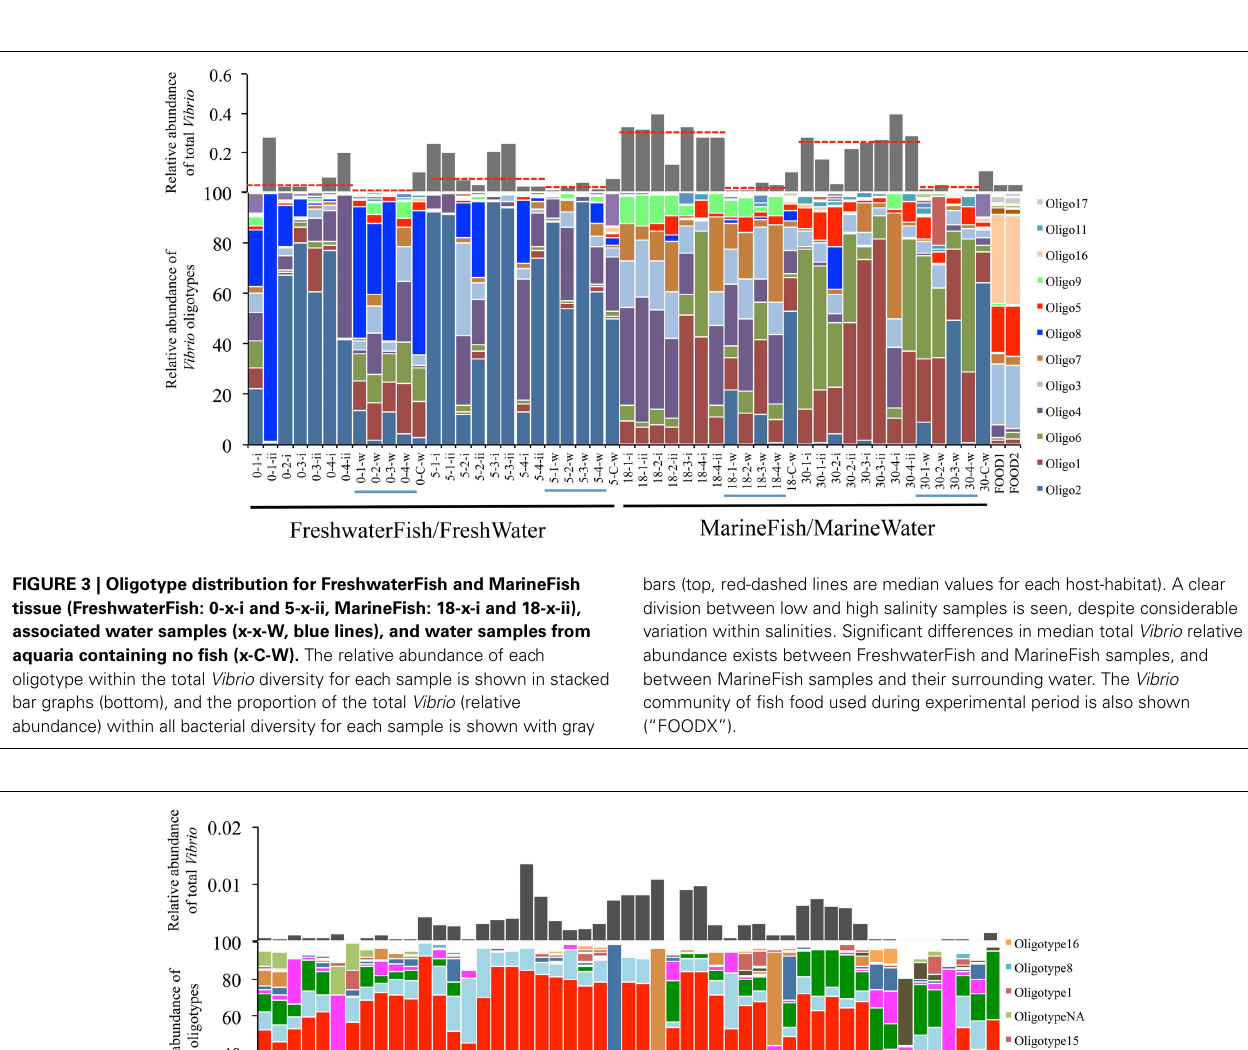
surface. Black arrows indicate plastic samples that contain a single oligotype at greater than 50% relative abundance. “OligotypeNA” represents